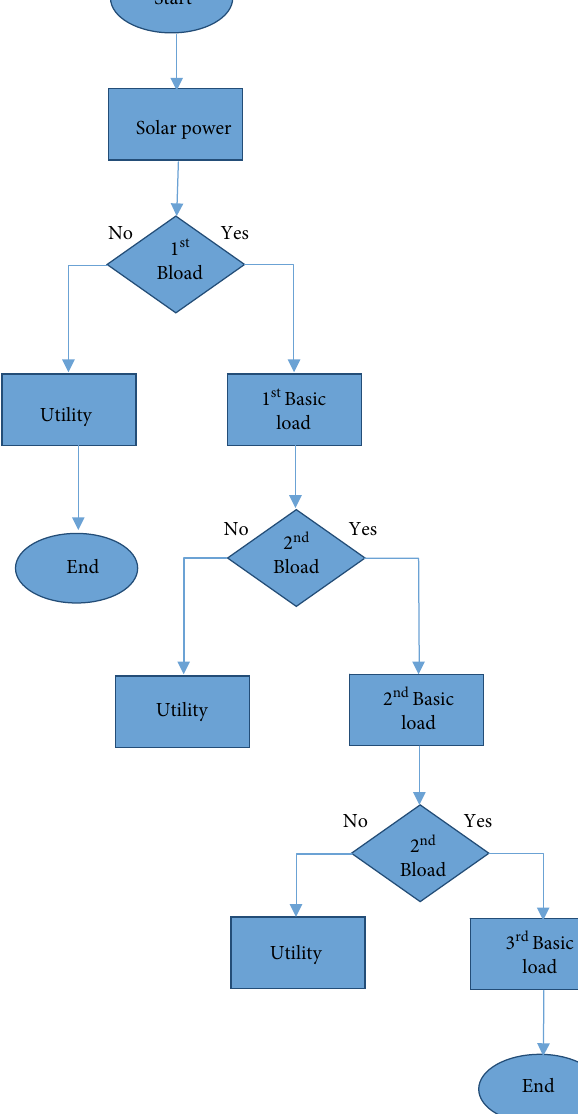
Figure 17: Basic load controller fl